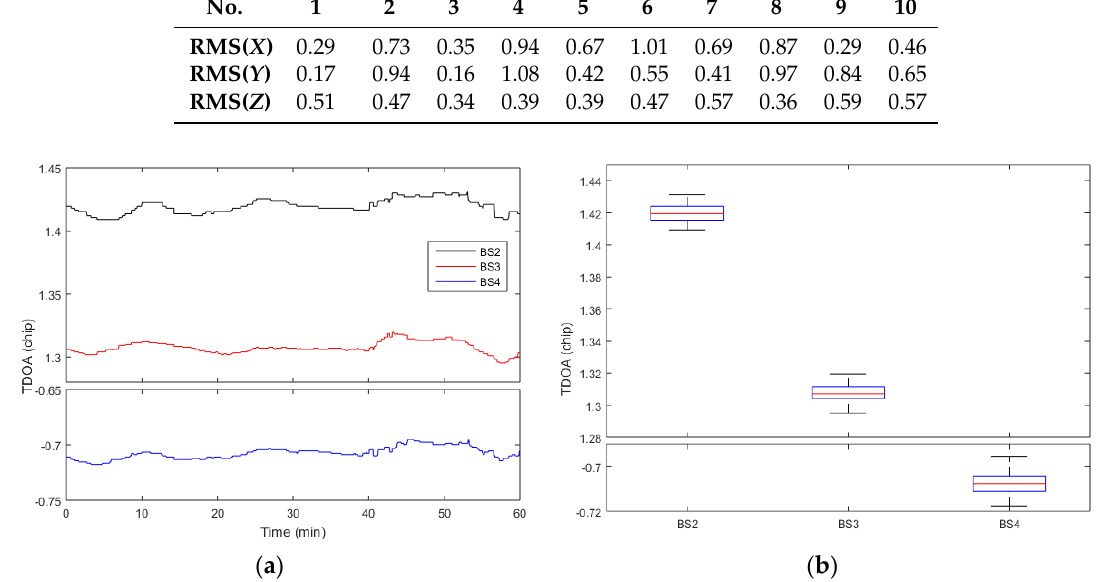
Figure 19. The TDOAs for the No. 1 point of the 3rd floor: ( a ) is the fluctuations with time and ( b ) is the corresponding boxplot. Table 2. Standard deviation of the 3rd floor positioning results.